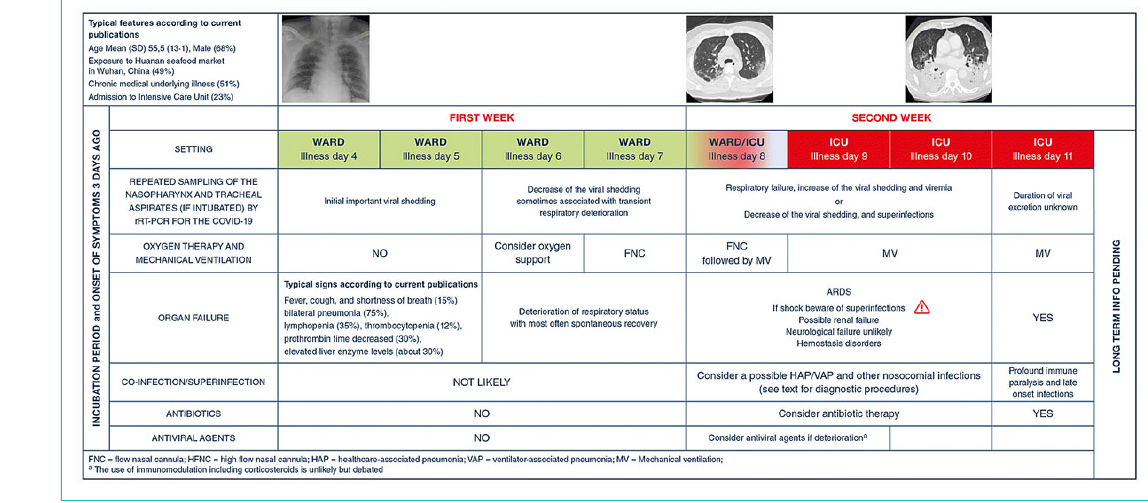
Figure 1: Global picture of severe cases. From [2]: Bouadma L, Lescure FX, Lucet JC, Yazdanpanah Y, Timsit JF. Severe SARS-CoV-2 infec- tions: practical considerations and management strategy for intensivists. Intensive Care Med. 2020 Feb 26 [Epub ahead of print]. © 2020 Springer-Verlag GmbH Germany. Reprinted by permission from Springer